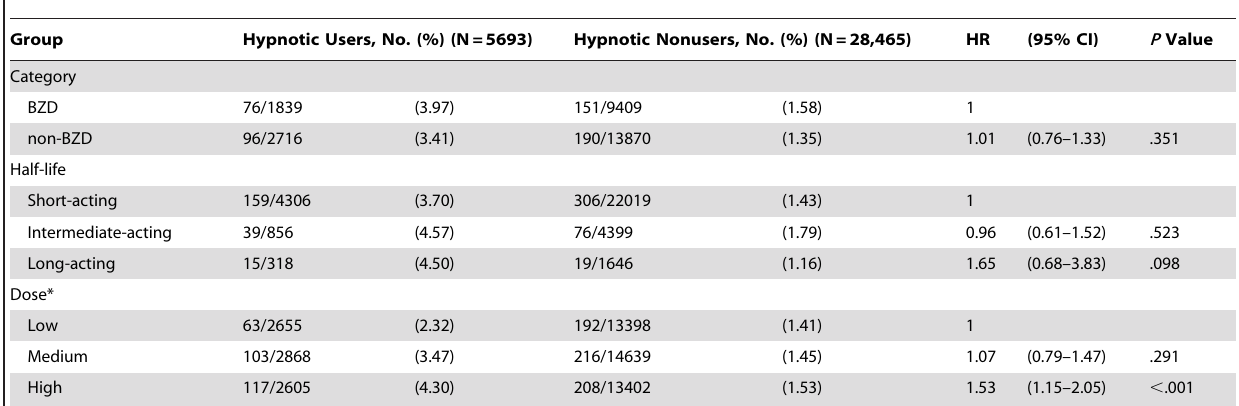
Table 4. Hazard ratios of dementia in patients with and without hypnotic usage stratified by categories of hypnotics, half-lives of hypnotics and doses of